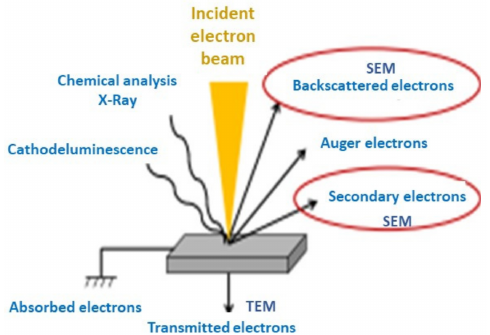
Figure 4. Different types of signals generated in SEM and TEM analysis. The most important are circled in red